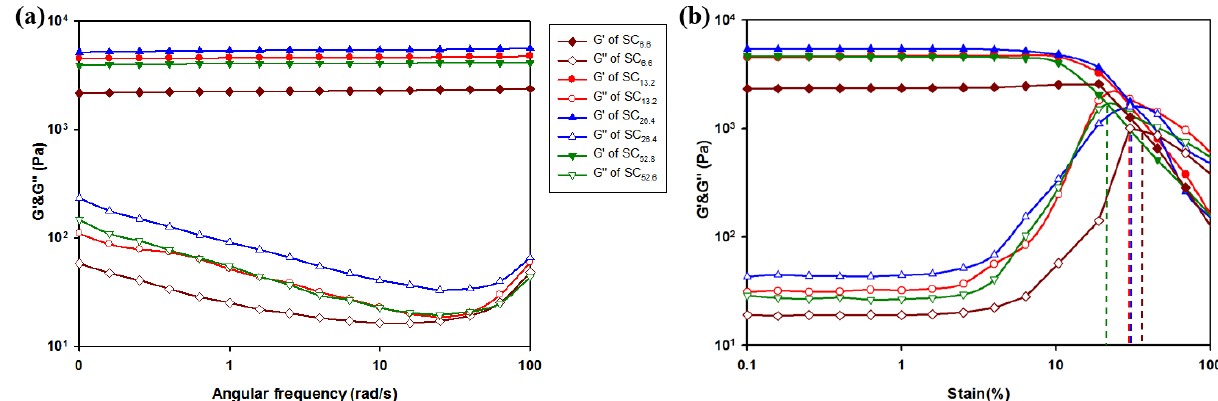
Figure 8. Rheological measurement for SCx: ( a ) oscillation angular frequency sweep test and ( b ) stress oscillation strain amplitude sweep test. Storage modulus (G ′ , filled symbols) and loss modulus (G″, empty symbols) of hydrogel was measured as a function of angular frequency (0.1–100 rad/s) and strain sweep (0.1–100%).